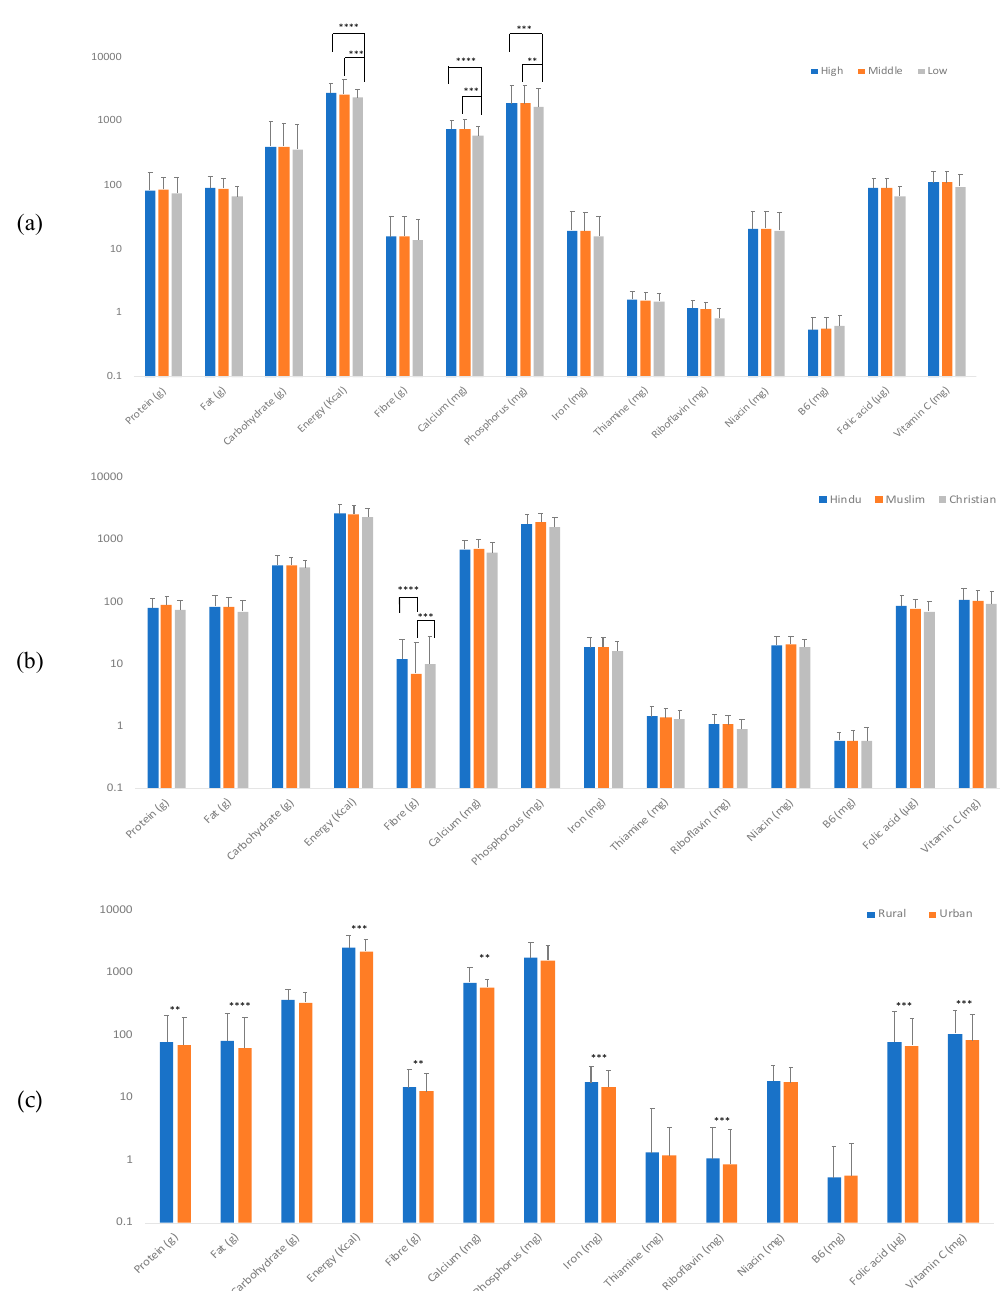
Figure 1. Mean nutrient intakes derived from the first FFQ across ( a ) income, ( b ) religion, ( c ) domicile. * Bonferroni adjusted p values. ** p < 0.005; *** p < 0.0005; **** p < 0.0001.